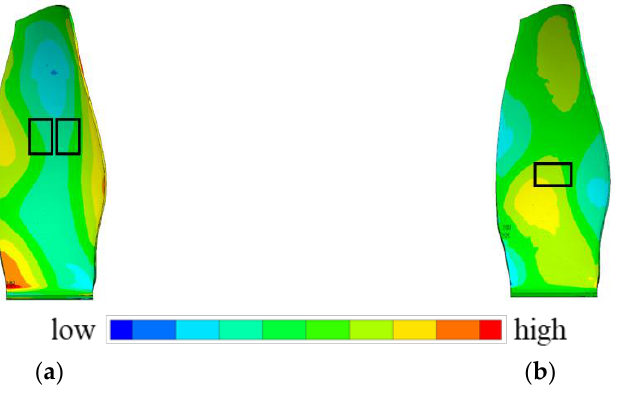
Figure 8. Modal strain of mode 3: ( a ) Spanwise modal strain; ( b ) Chordwise modal strain.